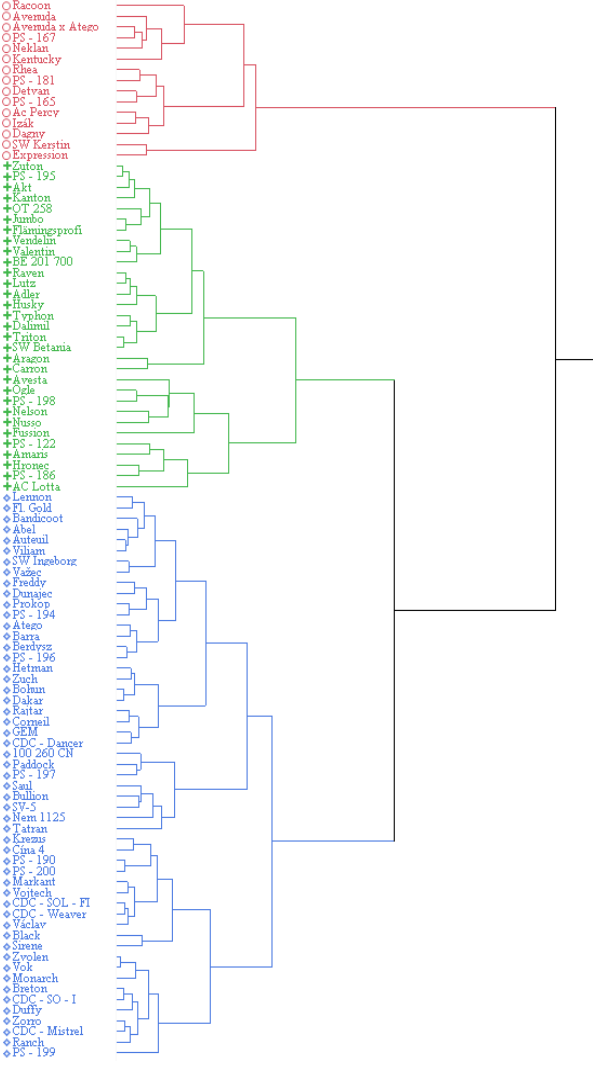
Figure 8: Cluster analysis of oats according to protease inhibitory activities to trypsin (IA_TY), thrombin (IA_TR), urokinase (IA_UR), elastase (IA_ELA), and cathepsin B